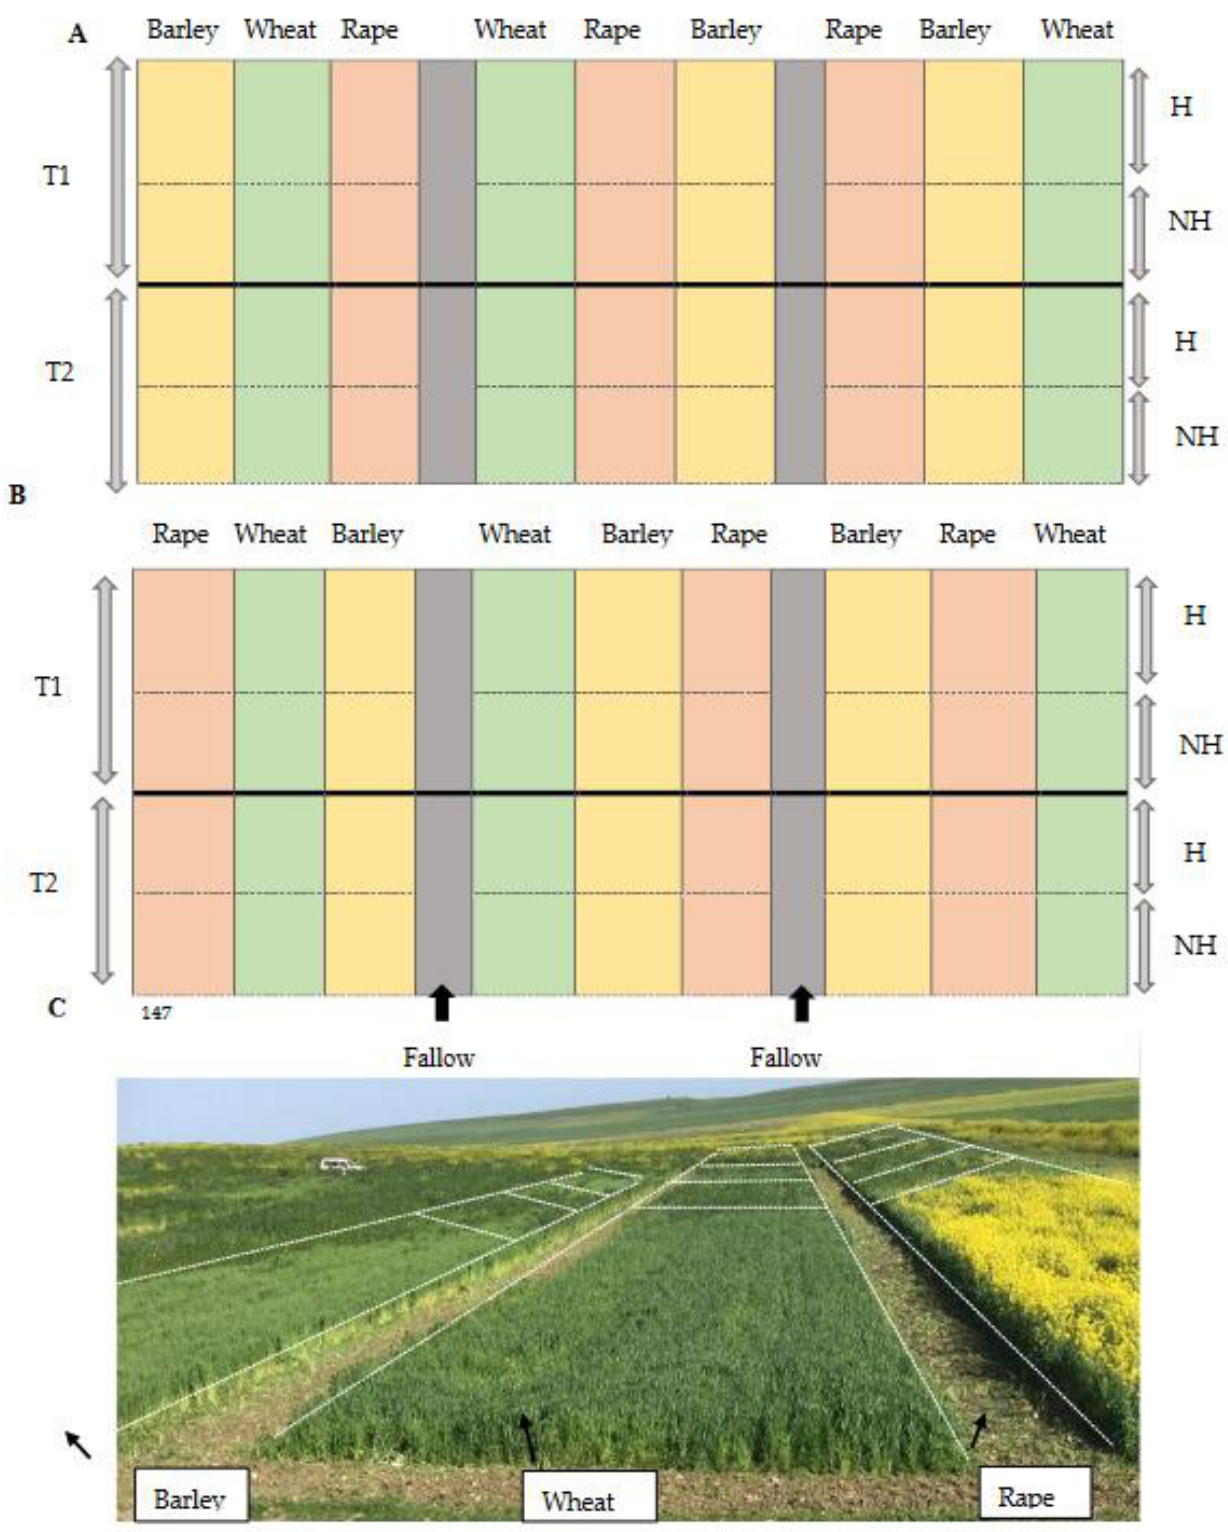
Figure 1. Schematic representation of the experimental design in ( A ) 2017–2018 and ( B ) 2018–2019 growing seasons; ( C ) Picture of the experimental unit (one repetition) within the field. T1 = Conventional tillage; T2, reduced tillage; H = with herbicide treatment; NH = without herbicide treatment.